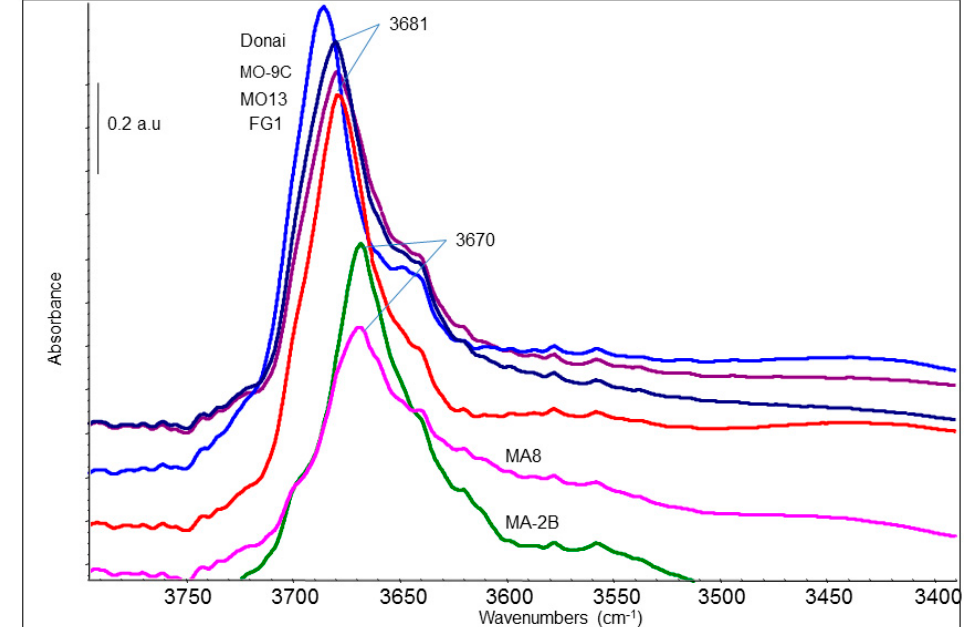
Fibers 2019 , 7 , x FOR PEER REVIEW Figure 6. FT-IR spectra of the serpentinites in the 3800–3350 cm − 1 range. Figure 6. FT-IR spectra of the serpentinites in the 3800–3350 cm − 1 range.